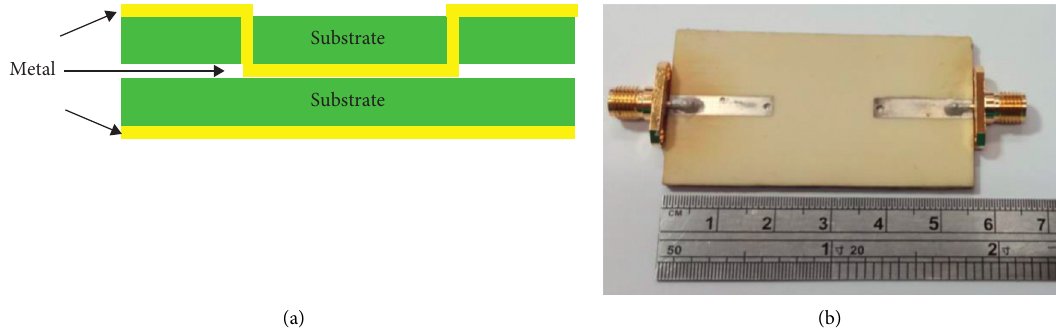
Figure 2: (a) The geometry of the fully inkjet-printed microstrip line and (b) the photograph of the test piece.